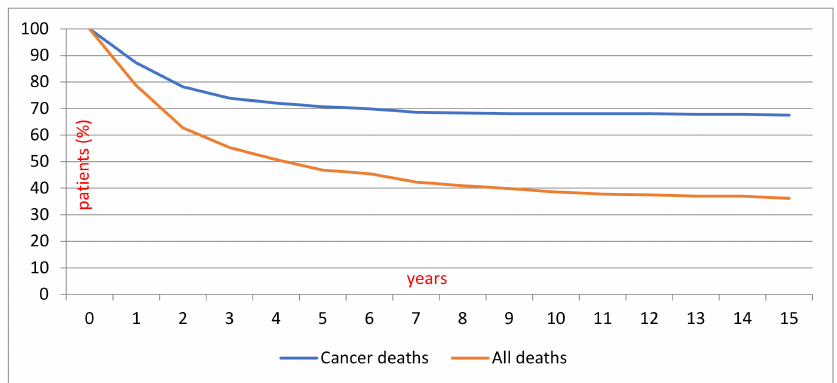
Figure 2. Kaplan–Meier curve depicting MCC specific deaths compared to all MCC patient deaths in 1986–2016.